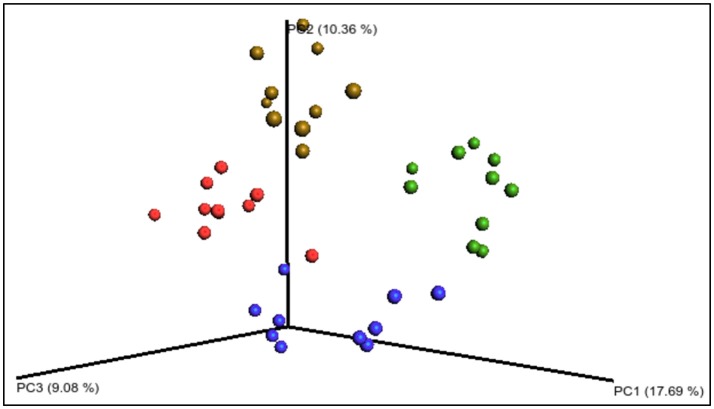
Principal coordinates analysis PCoA of the unweighted UniFrac distances of the 168 sequencing data. The four diet groups are represented by colored circles: blue—starch dough (SD), green—starch dough containing nisin (SD-N), red—starch gel (SG), brown—starch gel containing nisin (SG-N). The groups are significantly different (p = 0.001, n = 10).